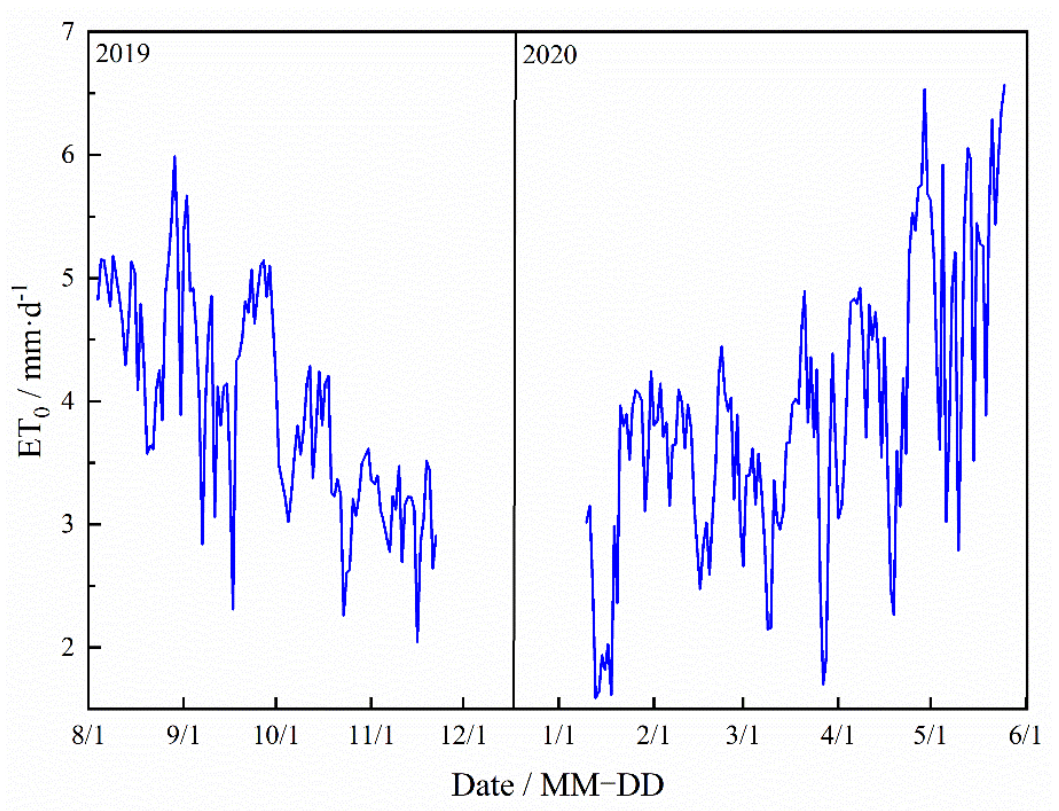
Figure 4. Variation in the reference crop evapotranspiration (ET 0 ) in the solar greenhouse from 2019 to 2020.